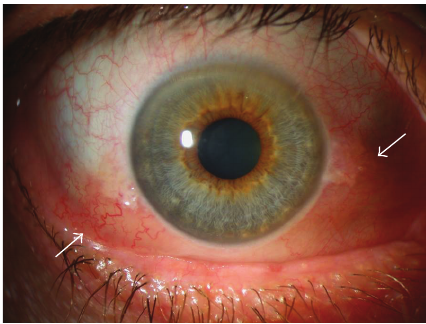
Figure 2: Chemosis. Notice the conjunctiva separated from the sclera and behind the grey line (arrows) and diffuse conjunctival redness.